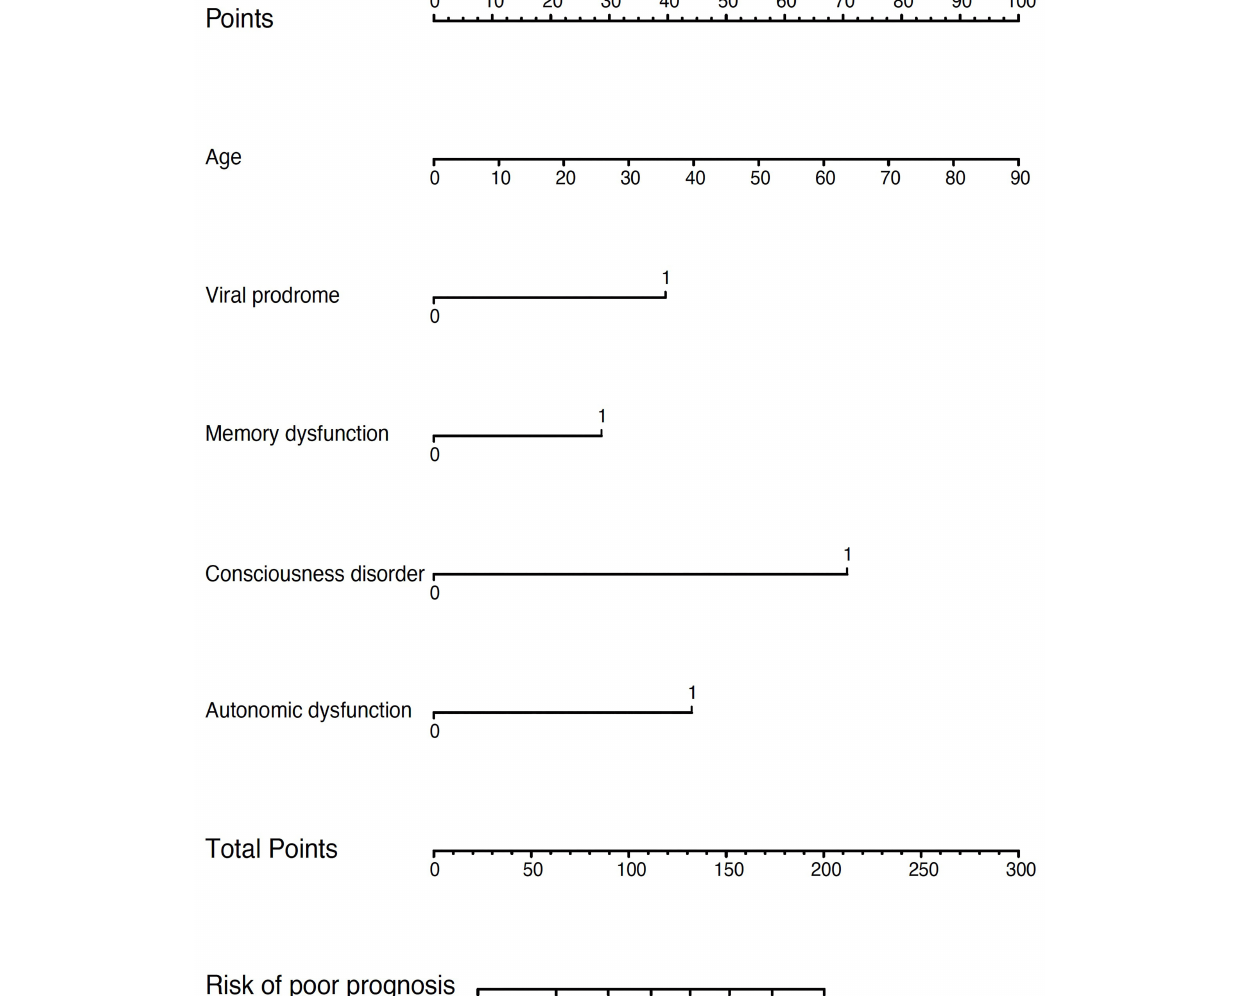
Frontiers in Neurology |